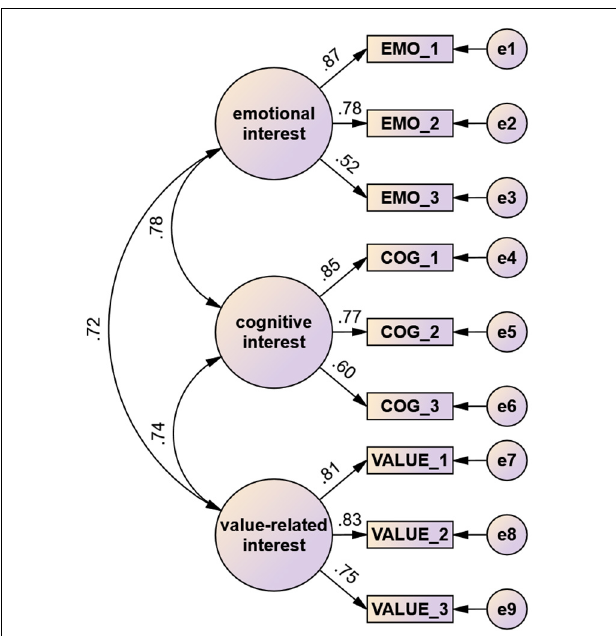
FIGURE 1 | Path diagram showing the standardized results of the confirmatory factor analysis of model 2. The values between the three factors are correlations. The values between the factors and items are standardized regression weights.